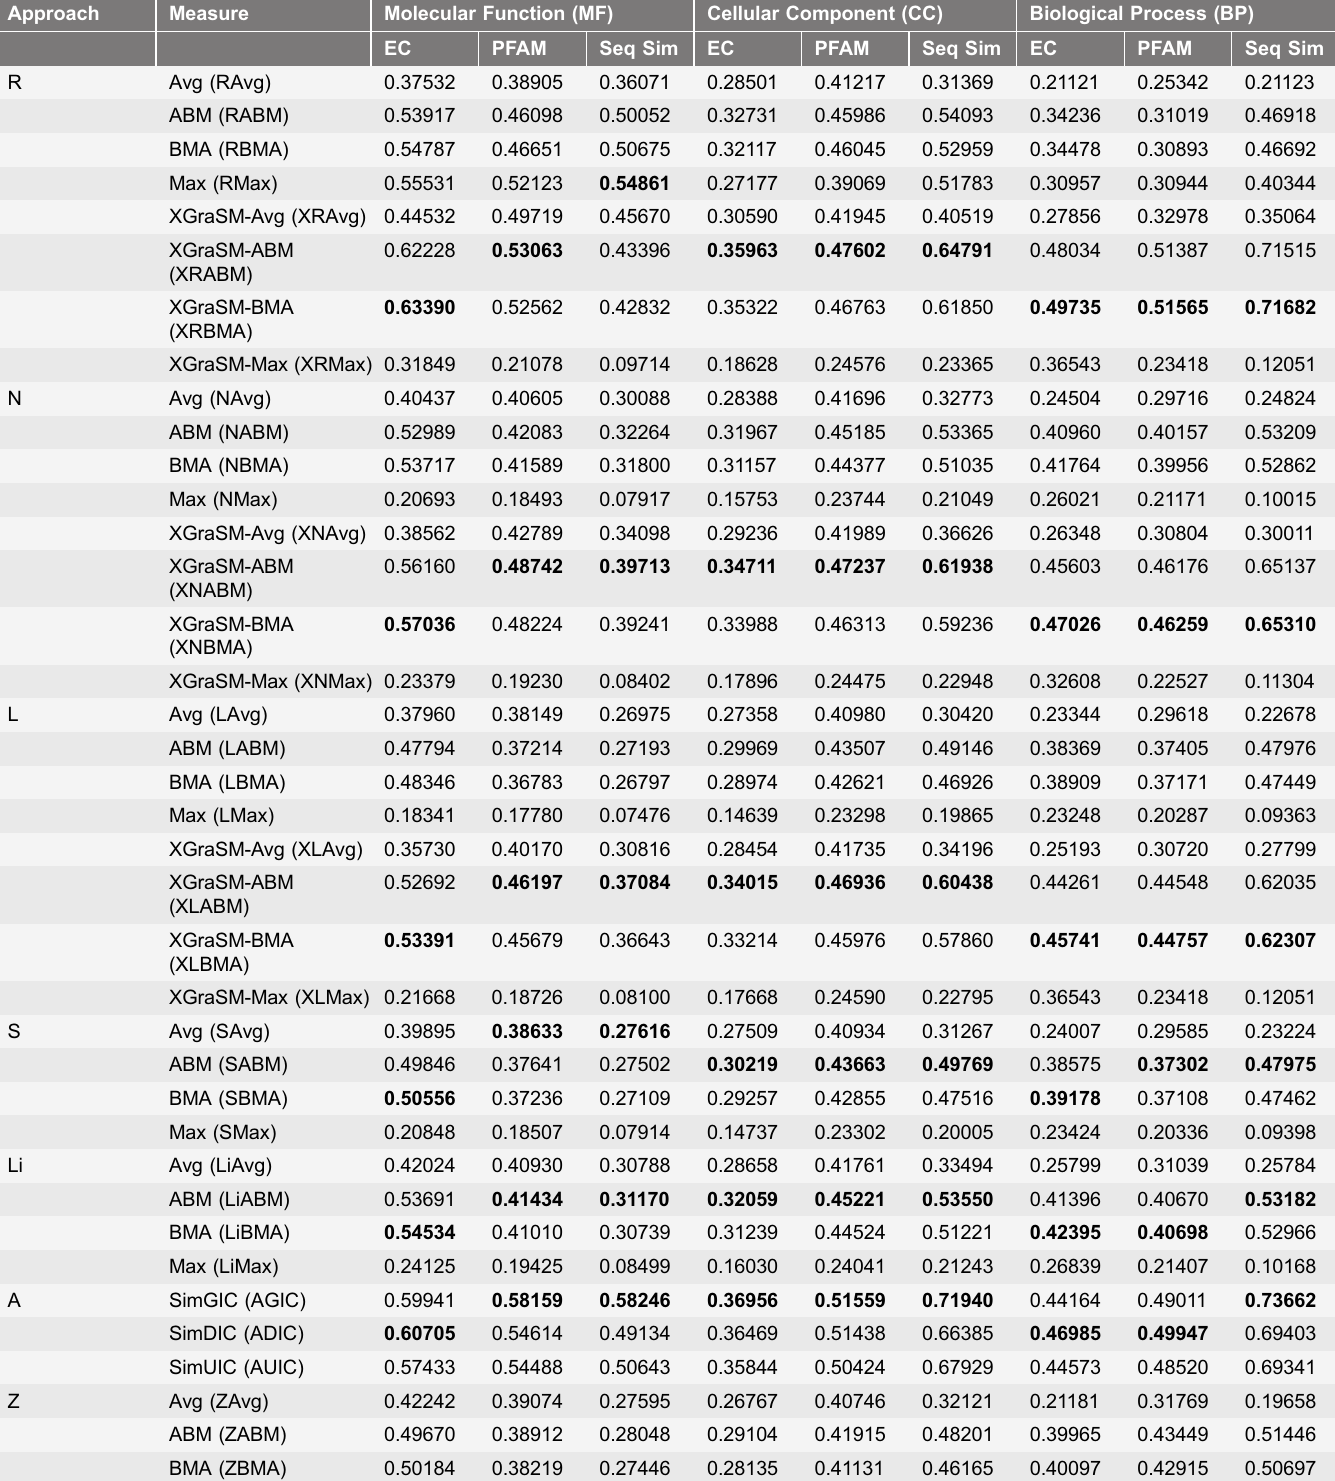
Table 2. Pearson’s correlation values of different